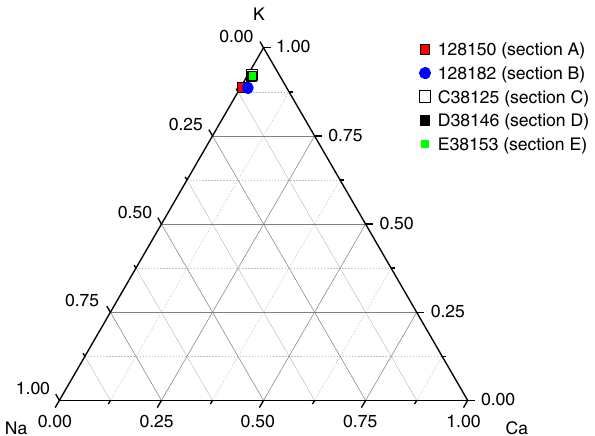
Fig. 8 Ternary diagram showing XRF analyses of fi ve K-rich feldspar extracts from Jingbian. Sample averages are based on the results from three-to-six aliquots (each aliquot measured three times). Grain size of K-feldspar extracts was 90 – 180 µ m, except for sample D38146 (90 – 125 µ